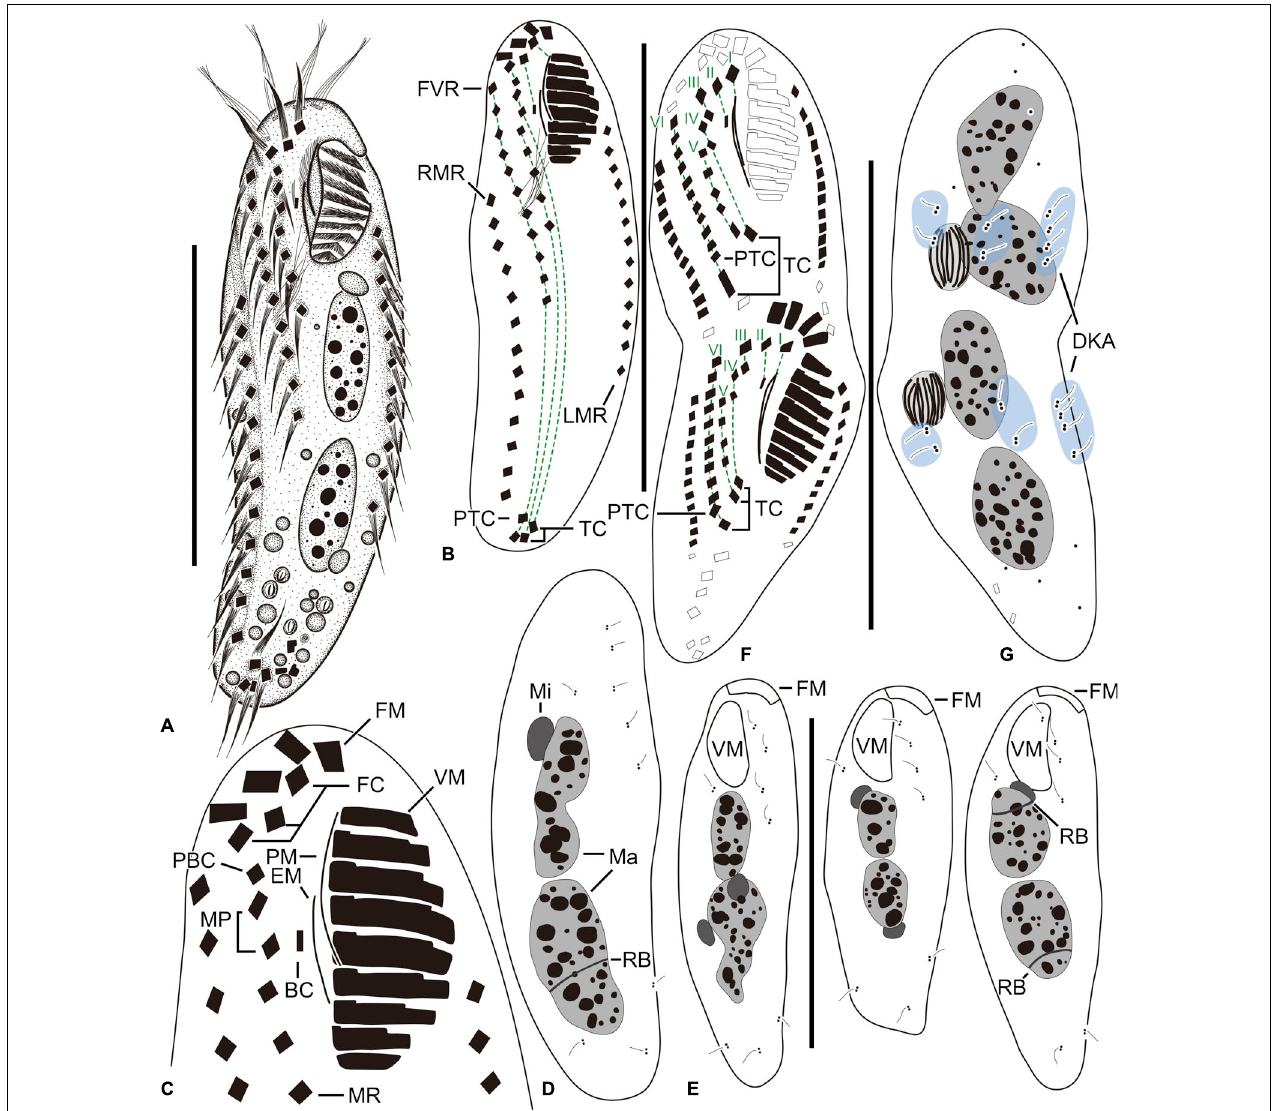
FIGURE 1 | Tunicothrix halophila n. sp. in vivo (A) and after protargol impregnation (B–G) . (A) Ventral view of a representative specimen. (B–D) Ventral (B,C) and dorsal (D) views of the holotype specimen. (E) Dorsal views showing dorsal bristles and nuclear apparatus. (F,G) Ventral (F), and dorsal (G) views of a late divider. BC, buccal cirrus; DKA, dorsal kinety anlagen; EM, endoral membrane; FC, frontal cirrus; FM, frontal adoral membranelles; I–VI, frontal-ventral transverse anlagen; FVR, frontoventral row; LMR, left marginal row; Ma, macronuclear nodules; Mi, micronuclei; MP, midventral pair; MR, midventral row; PBC, parabuccal cirrus; PTC, pretransverse cirri; RB, replication band; RMR, right marginal row; TC, transverse cirri; VM, ventral adoral membranelles. Scale bars 30 µ